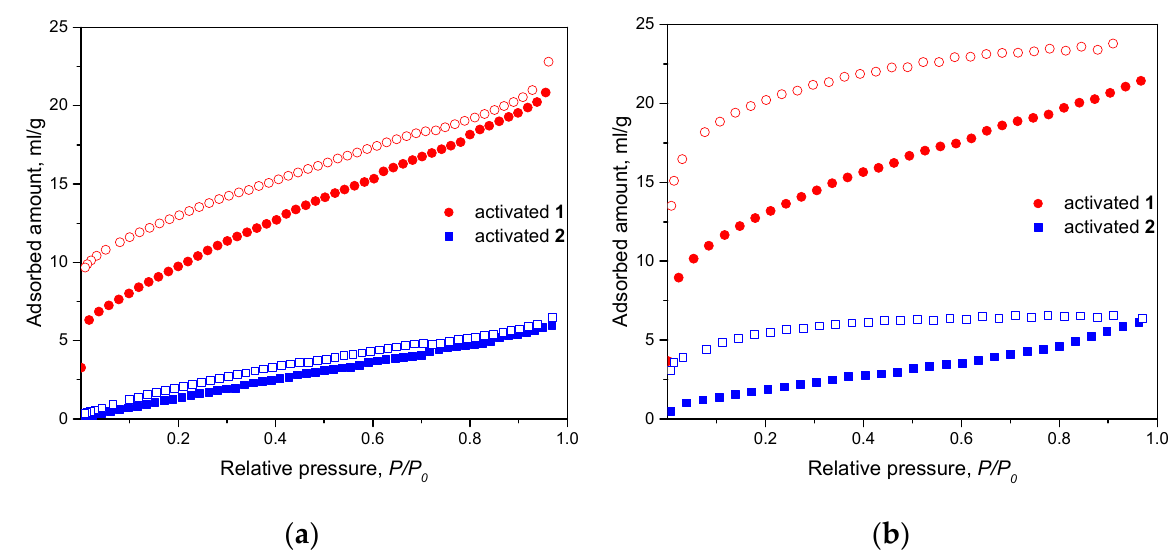
Figure 7. ( a ) N 2 sorption isotherms at 77 K for activated 1 and 2 ; ( b ) CO 2 sorption isotherms at 195 K for activated 1 and 2 . Adsorption curves is shown with filled symbols, desorption—empty symbols.